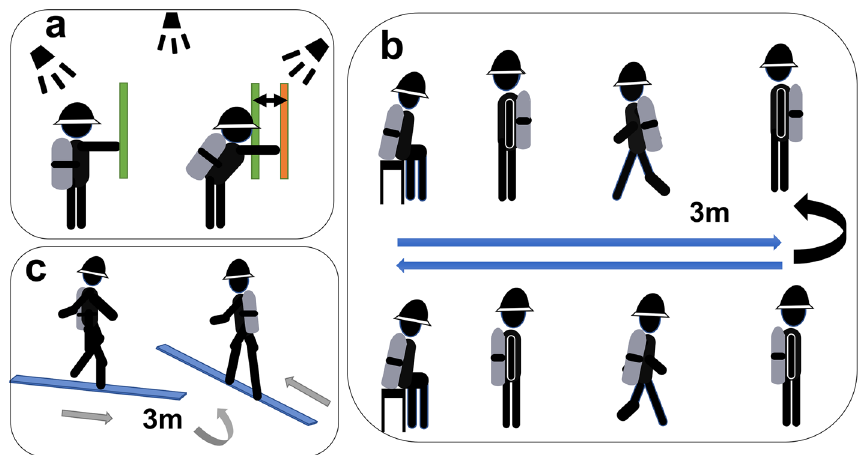
Fig. 1 Functional balance test. a Functional reach test: participants extended their right arms forward as far as possible with controlled balance; b timed up and go: participants stood up, walked in a straight line at their normal walking speed for 3 m, returned to the starting point, and sat down on the stool again without using their hands; c wooden plank time: participants crossed a 3 m wooden plank (height, 9 cm and width, 5 cm) from one end to the other while maintaining their balance and returned to the start